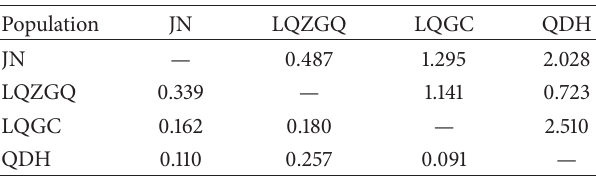
Table 4: Genetic differentiation of PhiPT analysis (below the diago- nal) and gene flow ( 𝑁 𝑚 ) (above the diagonal) among different pop- ulations in O. fragrans .